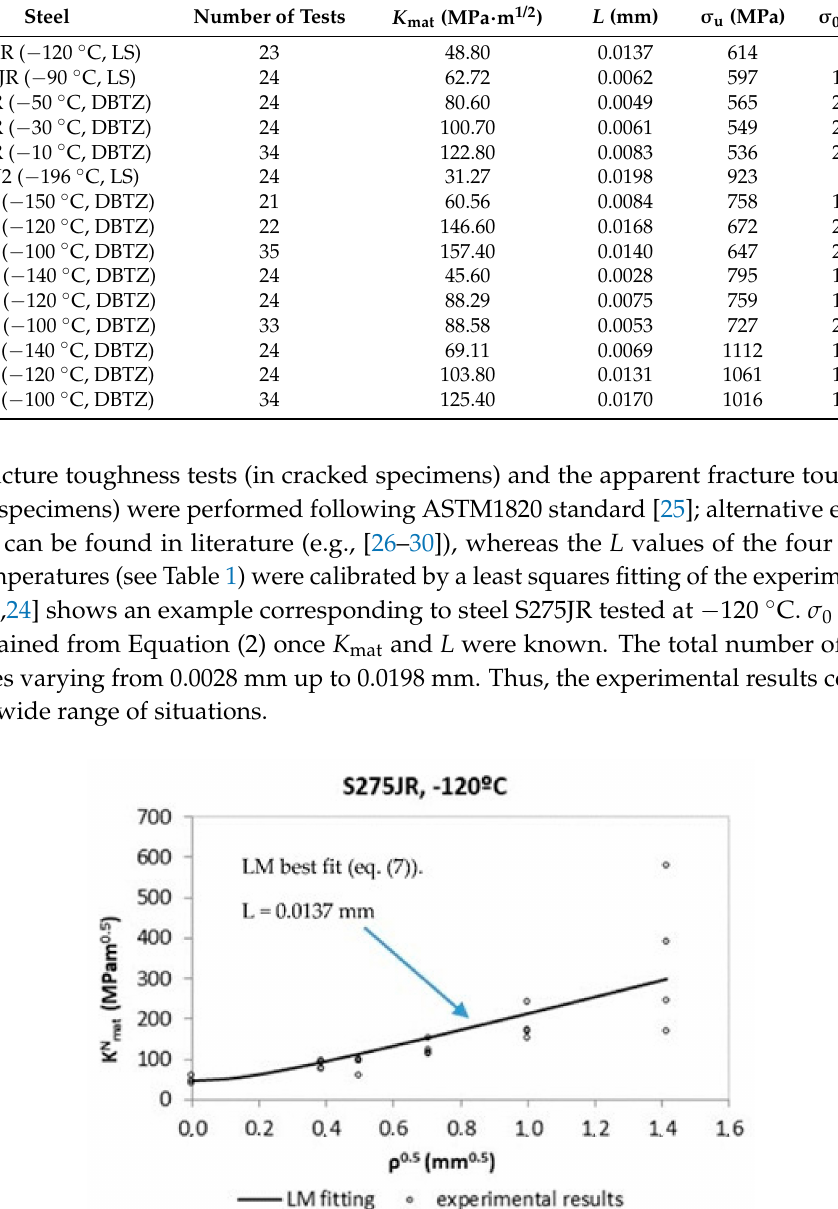
Table 1. Summary of the experimental results analyzed in this paper. LS: Lower Shelf; DBTZ: Ductile- to-Brittle Transition Zone [23,24].